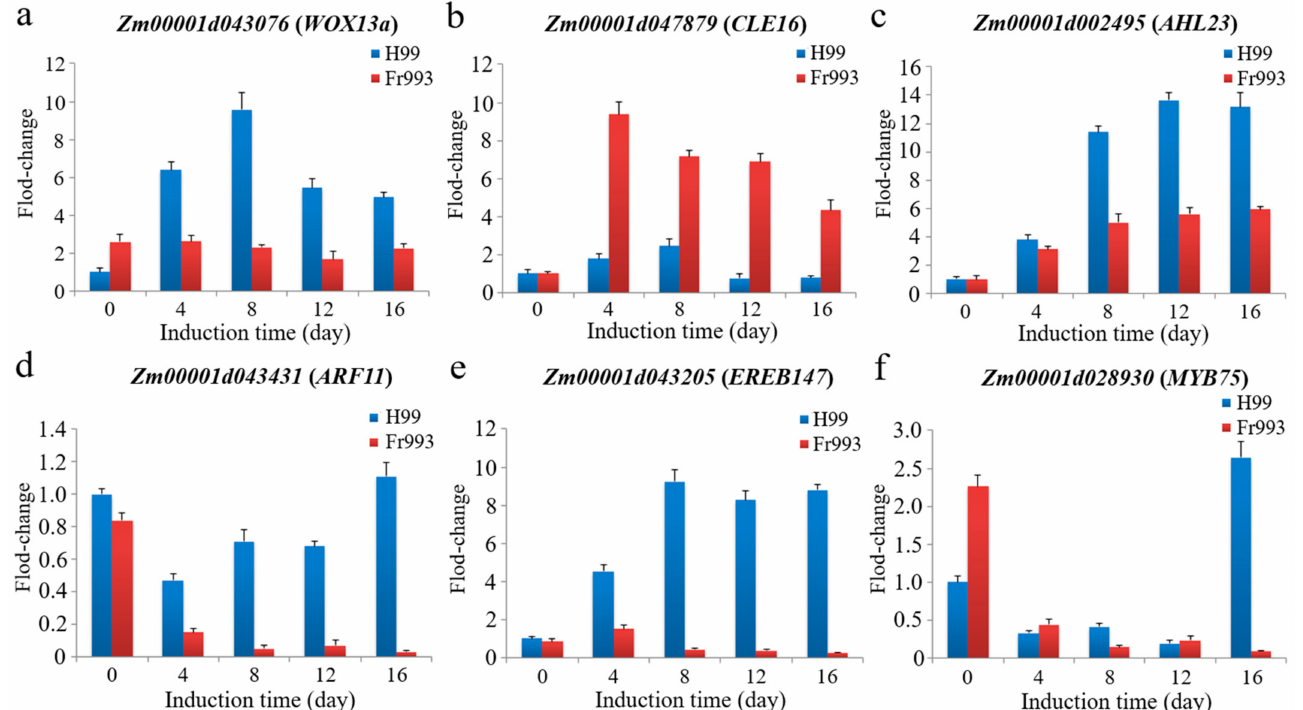
Figure 6. Expression profiles of the candidate genes at different induction stages. Here, H99 is a line with a high PRR (80.25%) and Fr993 is unable to regenerate. ( a – f ) Fold-changes of Zm00001d043076 ( WOX13a ), Zm00001d047879 ( CLE16 ), Zm00001d002495 ( AHL23 ), Zm00001d043431 ( ARF11 ), Zm00001d043205 ( EREB147 ) and Zm00001d028930 ( MYB75